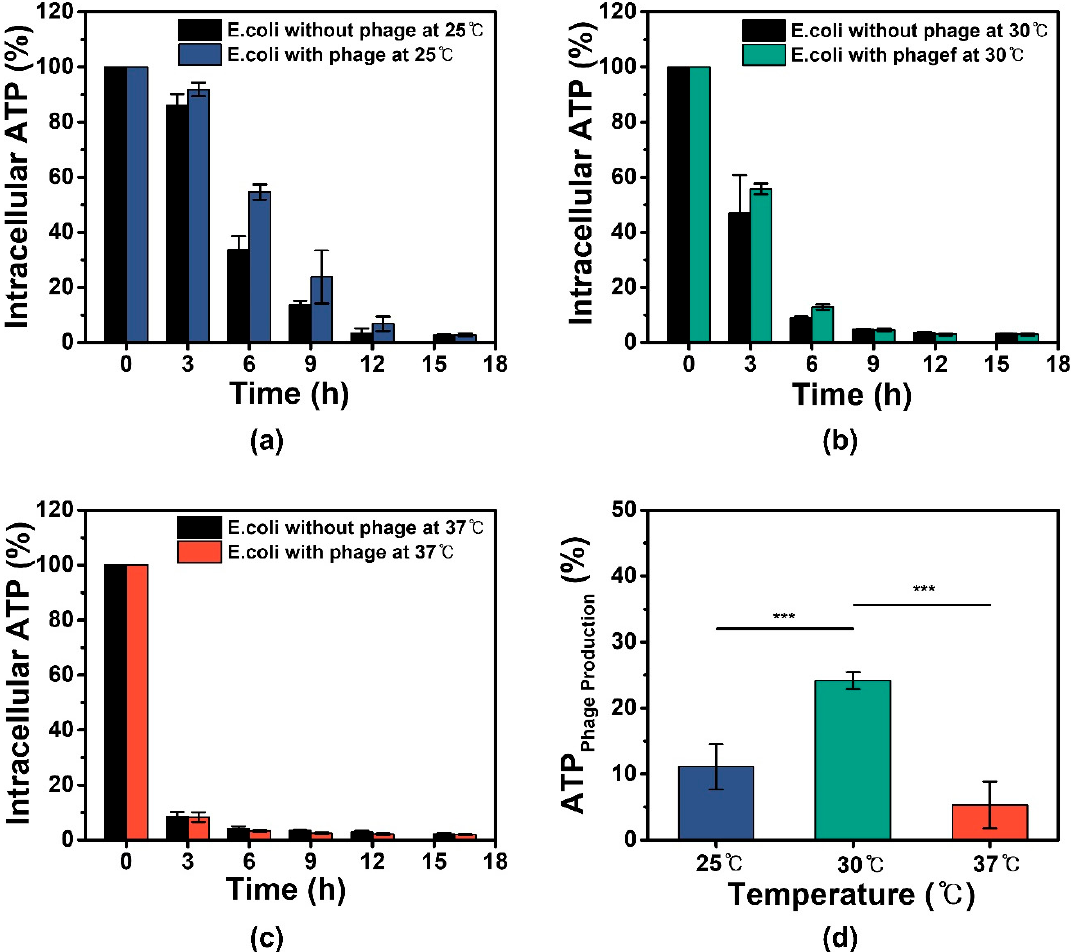
Figure 3. Intracellular ATP comparison and ATP expenditure for phage production at each culture temperature. Overnight cultures of XL1-Blue E. coli infected with and without M13 phage were fermented at different culture temperatures for 16 h. Samples of cells were extracted at 0, 3, 6, 9, 12, and 16 h of fermentation to calculate intracellular ATP percentages residing in the cells measured via ATP luciferase assay ( a ) at 25 °C, ( b ) 30 °C, ( c ) and 37 °C culture temperature. The ATP percentages were normalized by OD 600 of each sample. ( d ) Percentage of ATP expenditure for phage production was obtained using Equation (S7), which was highest at 30 °C culture temperature, followed by 25 °C and 37 °C. n = 3 for each data point. *** p < 0.001.